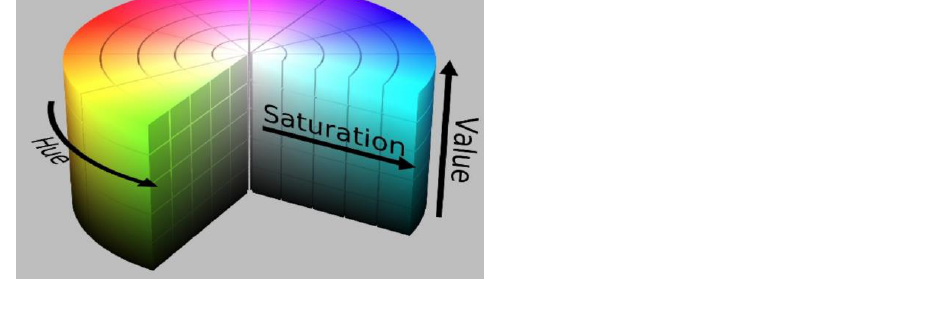
Figure 4. Color spectrum in HSV model from: https://my.oschina.net/u/4851203/blog/4825518 (accessed on 18 August 2021). Table 1. Value of hue channel of different color.